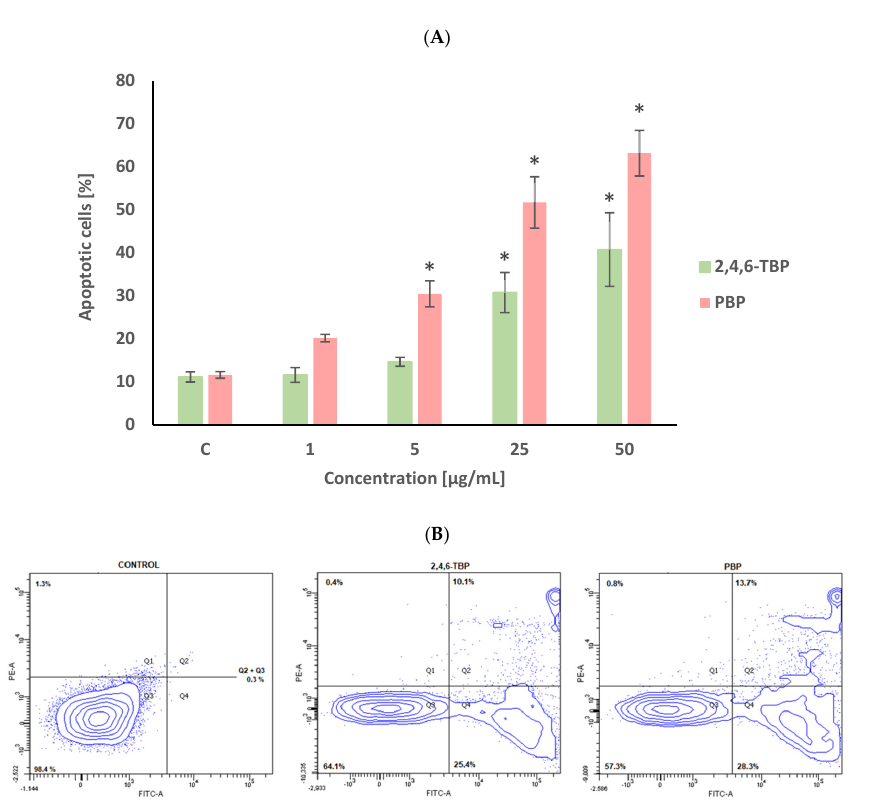
Figure 1. Apoptotic changes in human PBMCs incubated with 2,4,6-TBP and PBP in concentrations ranging from 1 to 50 µg/mL for 24 h ( A ). The cells were stained with Annexin V-FITC and propidium iodide. Exemplary dot plot showing apoptotic changes in human PBMCs unexposed (negative con- trol), as well as exposed to 2,4,6-TBP at 50 µg/mL and PBP at 25 µg/mL for 24 h, Q1—necrotic cells, Q2+Q3—apoptotic cells, Q4—live cells ( B ). (*) Means ± SDs were calculated from four individual experiments (four blood donors). Results were statistically different from negative control at * p < 0.05. Statistical analysis was conducted using one-way ANOVA and a posteriori Tukey test.